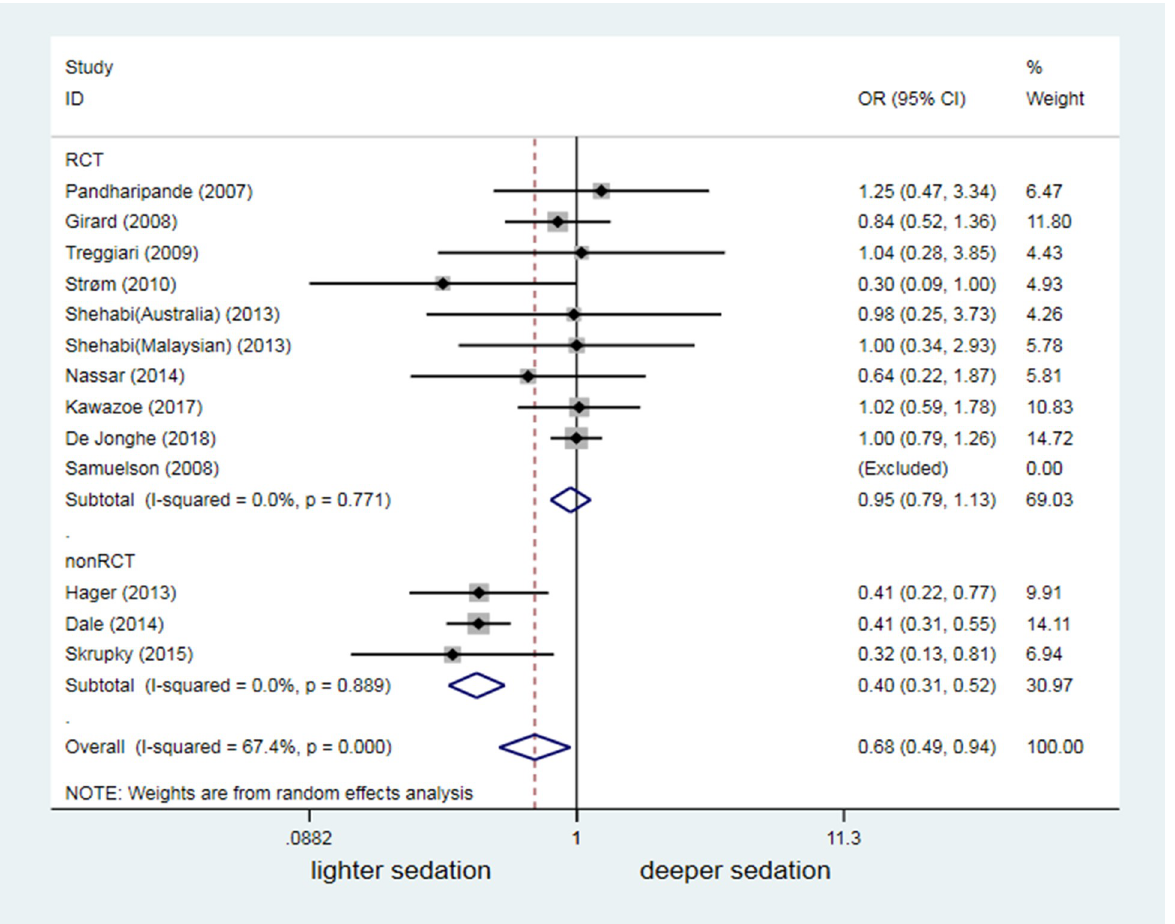
Fig 6. Odds ratio of different sedation depth affecting occurrence of delirium in trials without difference in severity of diseases between the lighter and the deeper sedation groups.